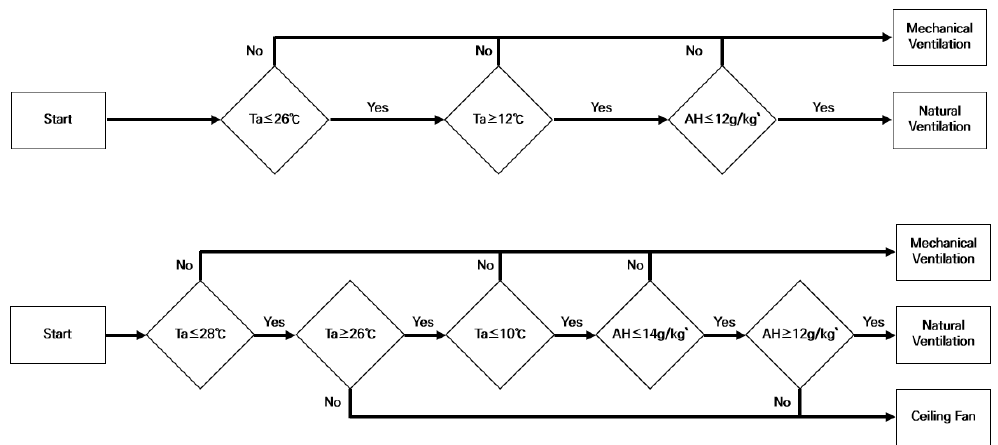
Figure 2. Conventional (Top) and proposed (Bottom) natural ventilation